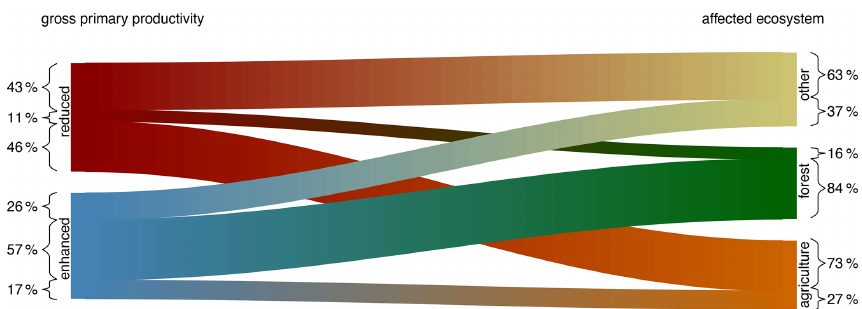
Figure 3. Proportion of GPP anomalies with reduced or enhanced productivity and their distribution in the different ecosystems (growing season events between 2003–2018). Bar sizes are proportional to the affected volume of the identified events. Numbers denote percentages of the affected volume for each of the categories. Forests tend to be associated with enhanced productivity rates, while agricultural ecosystems tend to be associated with reduced